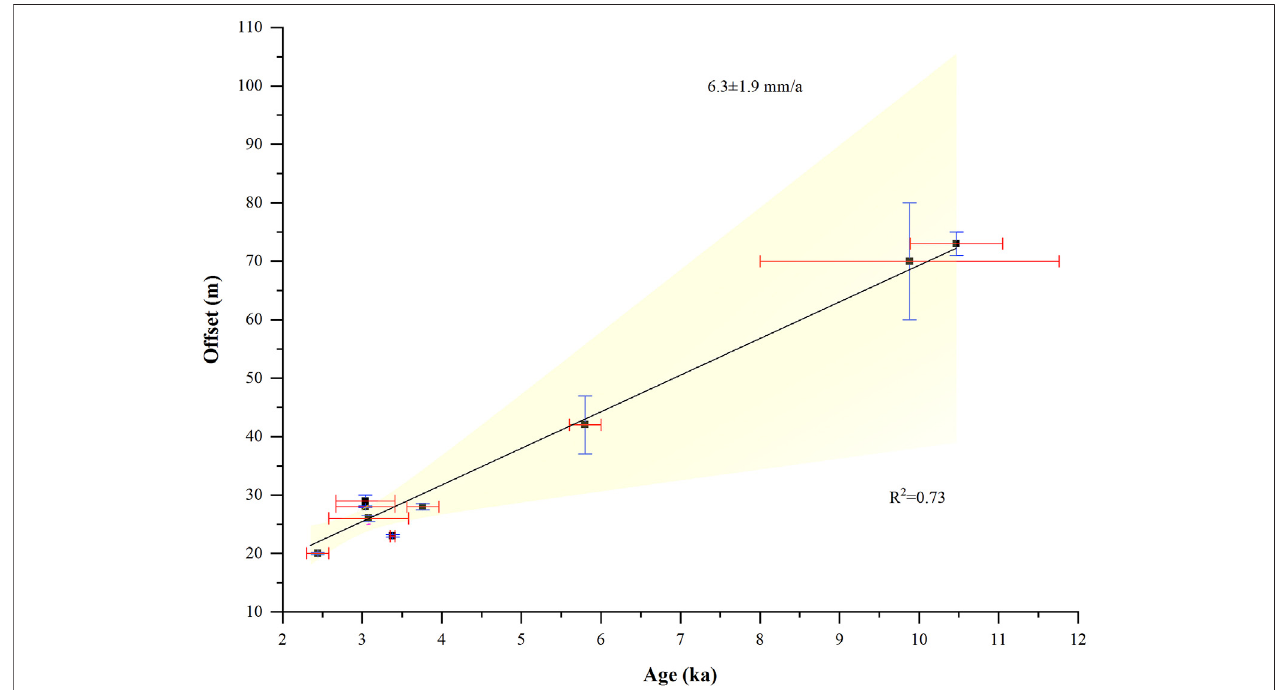
FIGURE 14 | Graph showing ages and offsets for individual sites along the DJF structure in the Holocene ( Table 3 ). Blue and red error bars are the respective offsets and ages measured in the fi eld. The linear fi tting result with a 95% con fi dence interval hints that the horizontal slip rate of the DJF in the Holocene is estimated at 6.3 ± 1.9